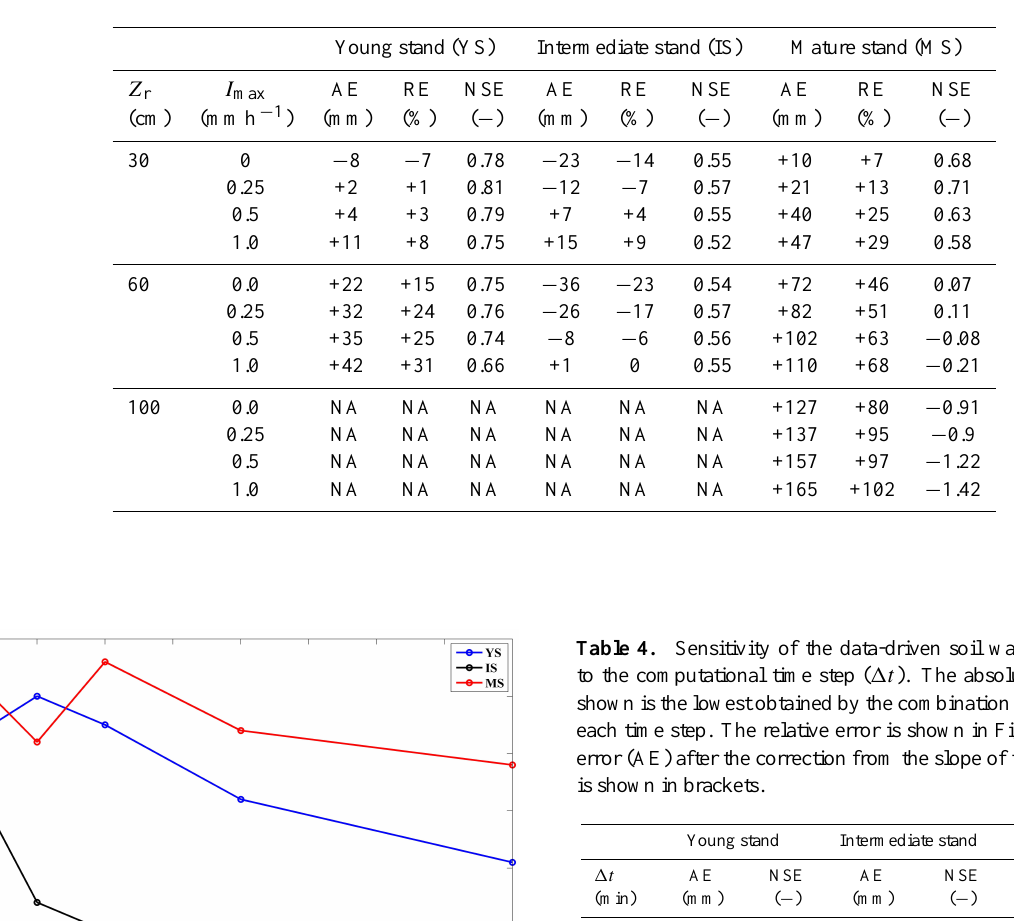
Table 3. The sensitivity of the model to soil depth, canopy interception and a fixed 1t =30min. The sensitivity is expressed as the absolute error (AE), relative error (RE) and Nash-Sutcliffe efficiency index from the mean total summer AET (mm) for the period 2001–2008. The lowest errors in each stand are highlighted in bold. Uncertainty derived from the energy imbalance is not considered.